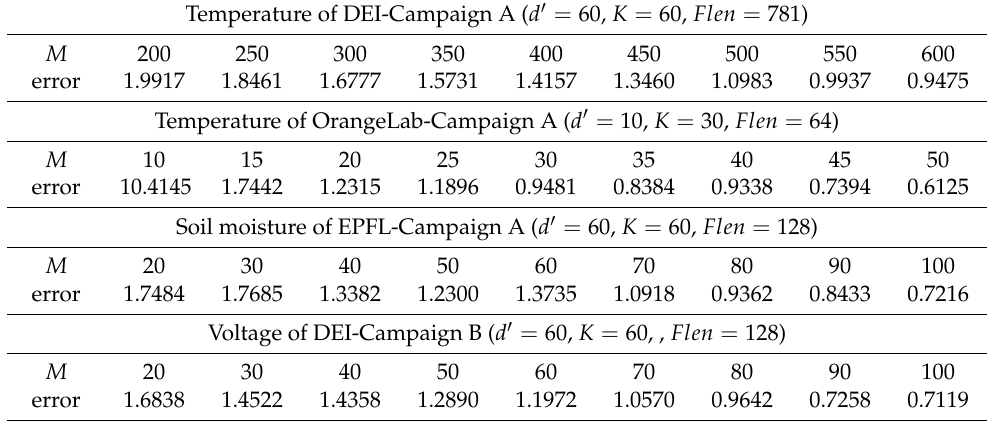
Table 5. Reconstruction errors of four different datasets vs. measurement M for